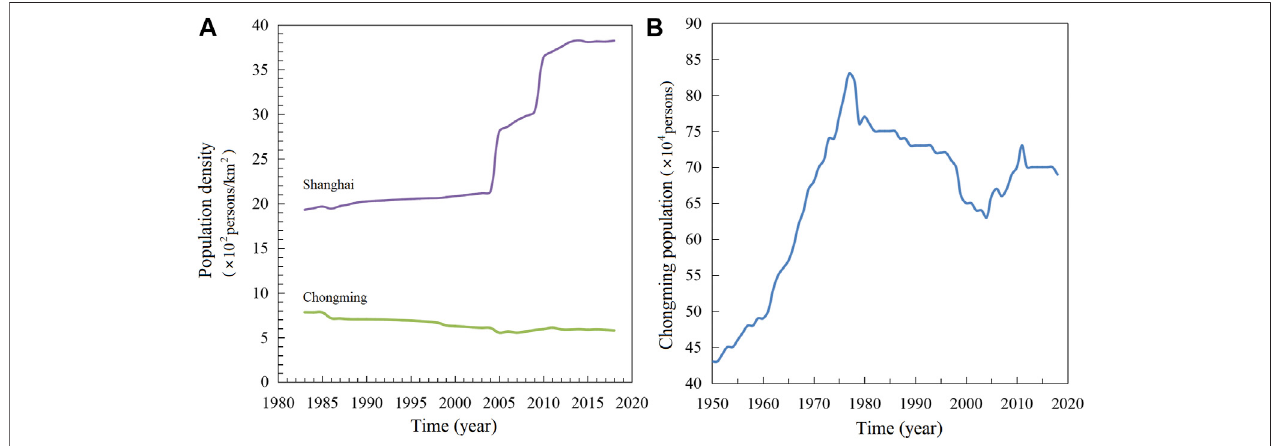
FIGURE11| PopulationchangesofShanghaiandChongmingDistrict: (A) populationdensitychangesduring1980 – 2018(afterShanghaiStatisticsBureau,2019); and (B) population changes of Chongming District since 1950 (Zhou, 1989; Shanghai Statistics Bureau, 2019).